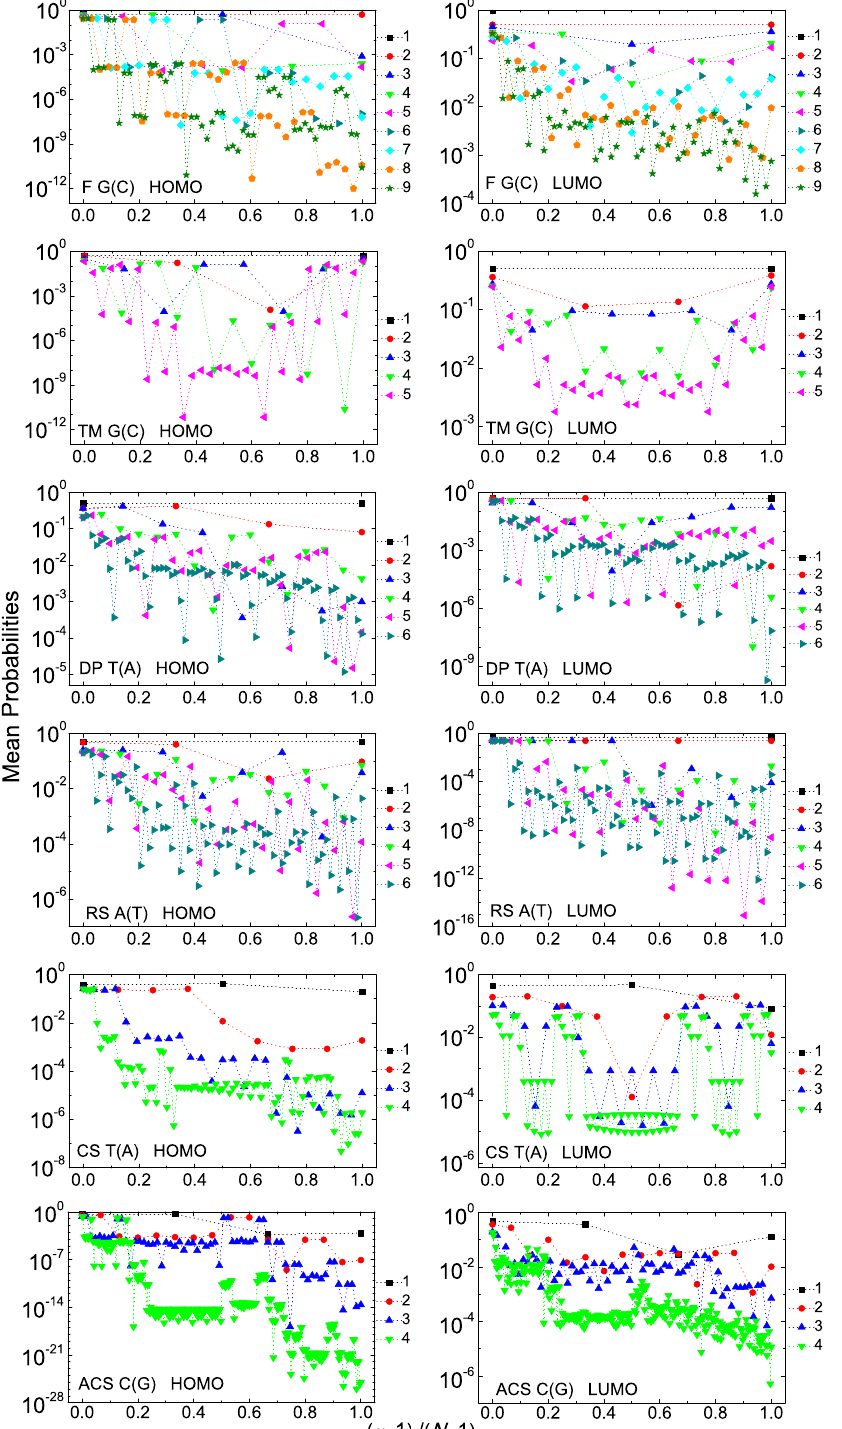
Figure A1. Mean over time probabilities to find the extra carrier at each monomer µ = 1, . . . , N , having placed it initially at the first monomer, for some consecutive generations, for G(C), TM G(C), DP T(A), RS A(T), CS T(A), ACS C(G) polymers, for the HOMO (left column) and the LUMO (right column). The notation of polymers is given in Table